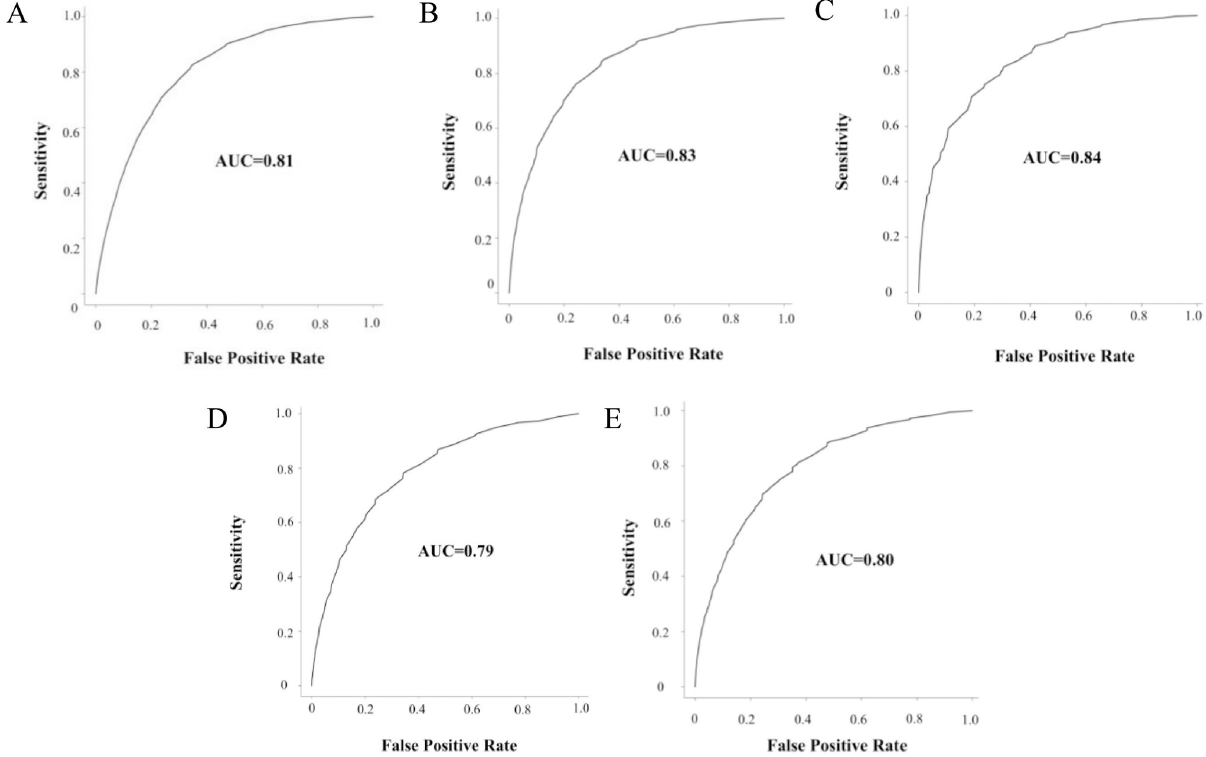
Fig 2. Receiver operating characteristic (ROC) curve for IQVIA Medical Research Data (IMRD) in A) UK B) France C) Germany D) Belgium E) Australia.